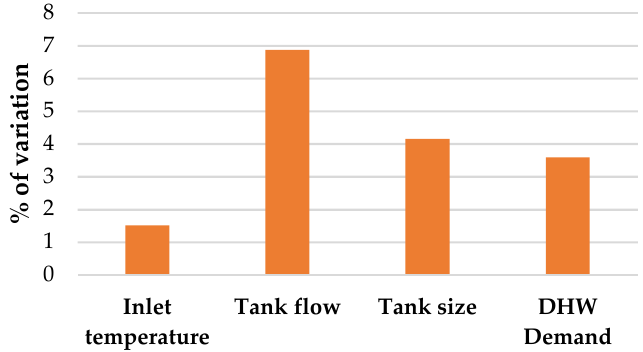
Figure 15. Ranking of the impact of parameters.